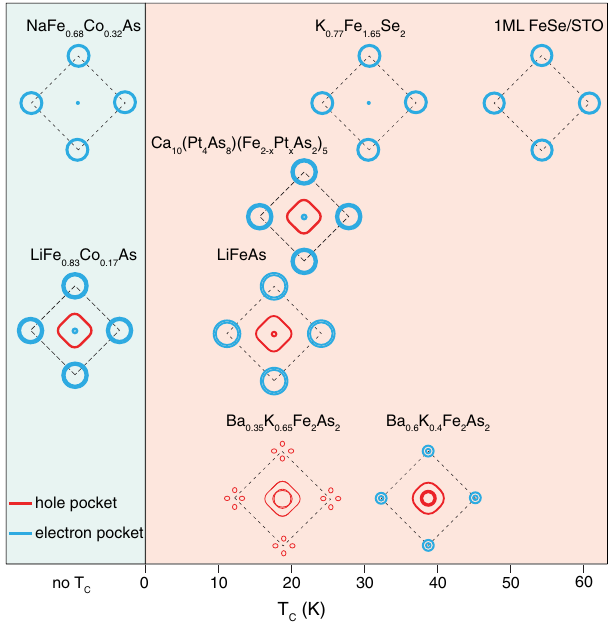
Fe 1 Se 2 , 1ML . 77 . 65